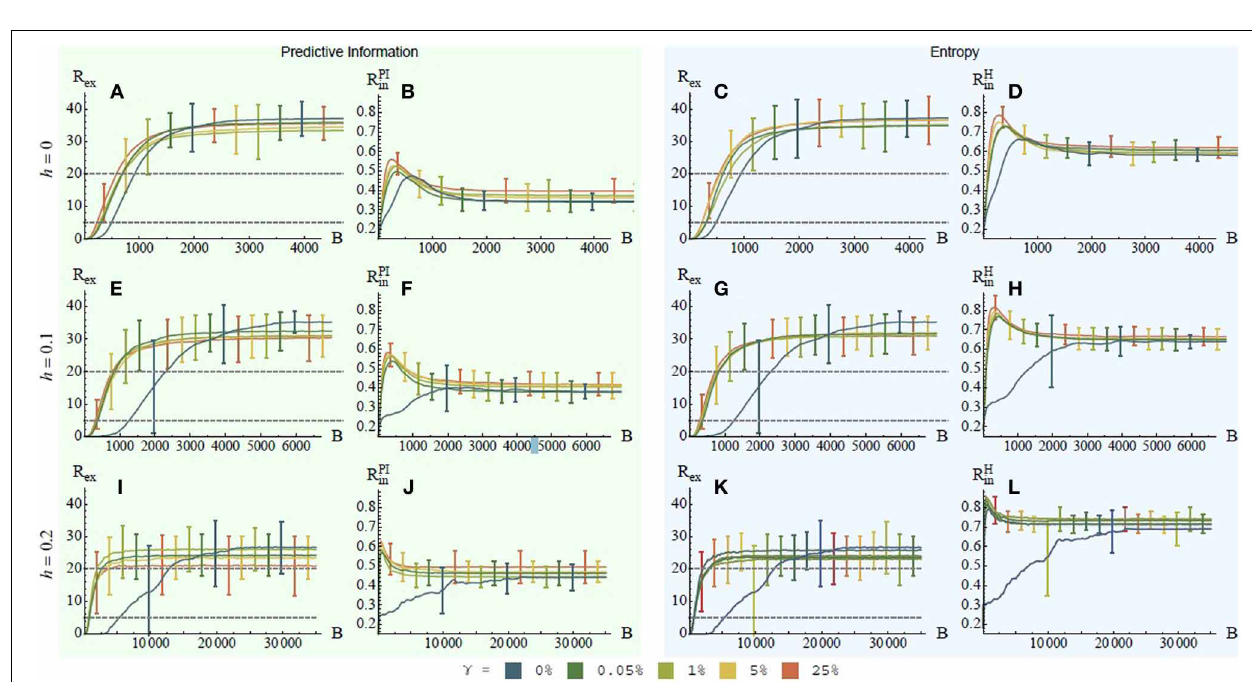
FIGURE 7 | Performance in the self-rescue task depending on the internal reward type and factor γ . Plotted are the ERF and the IRF in case of PI (A,B,E,F,I,J) and entropy (C,D,G,H,K,L) over the number of batches for different values of γ and barrier heights h : (A–D) no barrier ( h = 0), (E–H) low